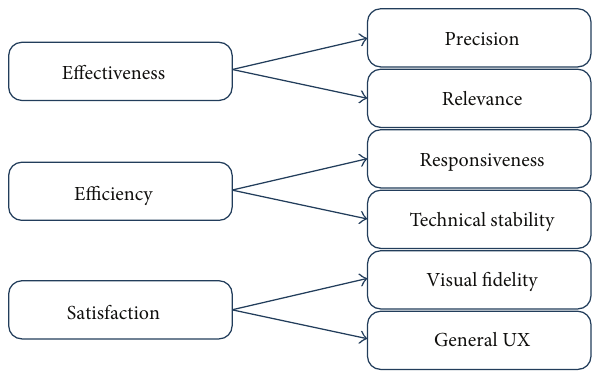
Figure 4: Six categories emerged from the ISO 9241-210.